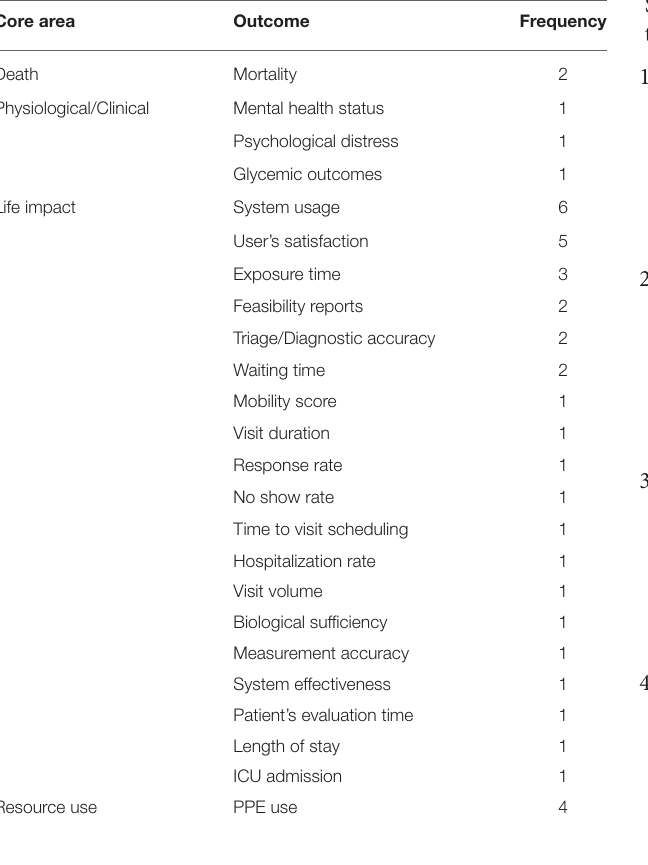
TABLE 2 | Outcomes classification and